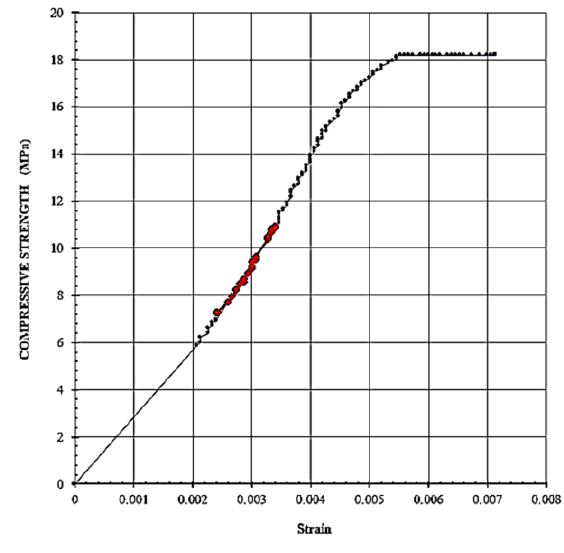
Figure 9. Elastic modulus of 30 % recycled